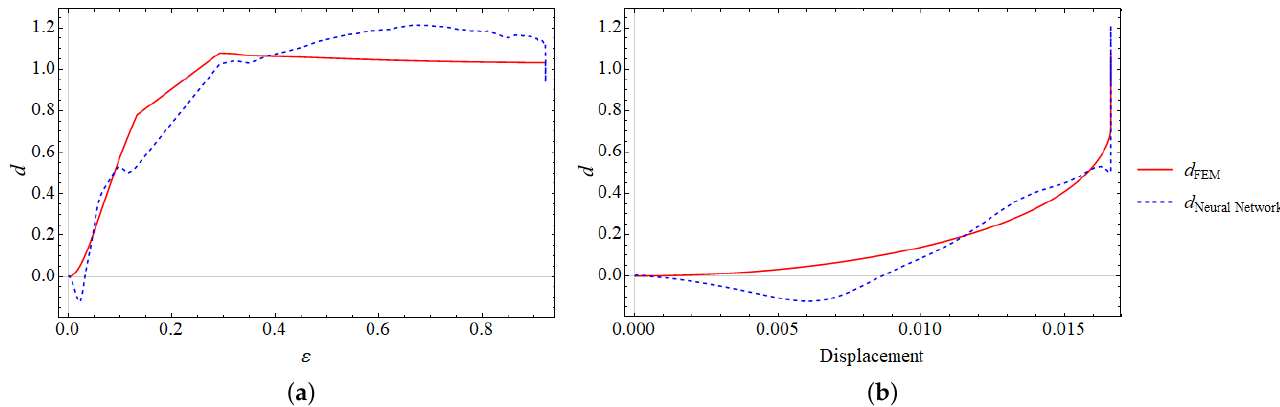
Figure 15. Case 1: Single-edge notched tension test. Fracture phase-field d curves versus strain ε in ( a ) and vs. displacement u in ( b